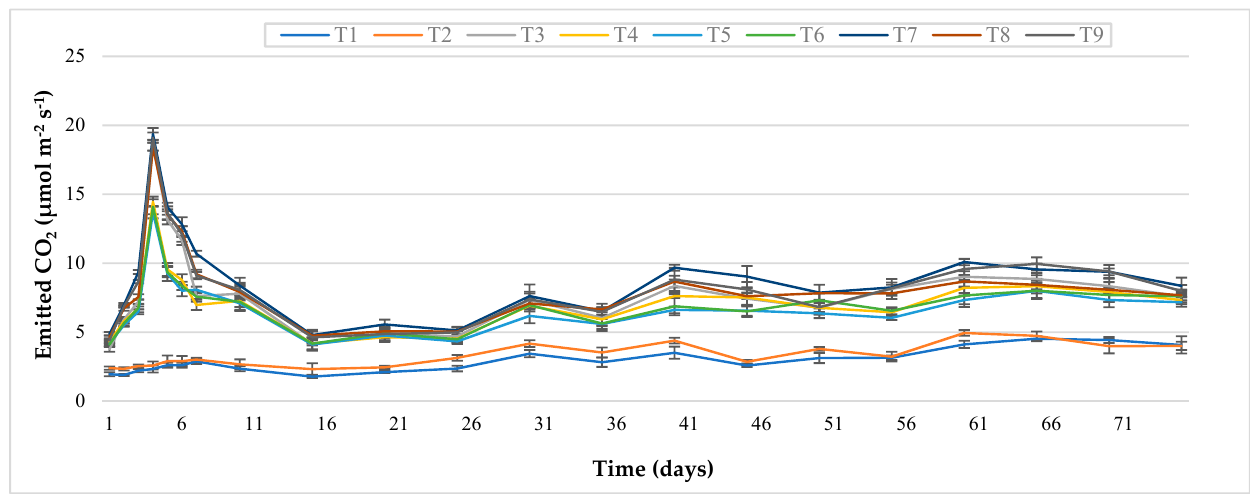
Figure 1. Effect of treatments on soil CO 2 flux emission in a maize field. Bar errors show ± standard error of four replications.